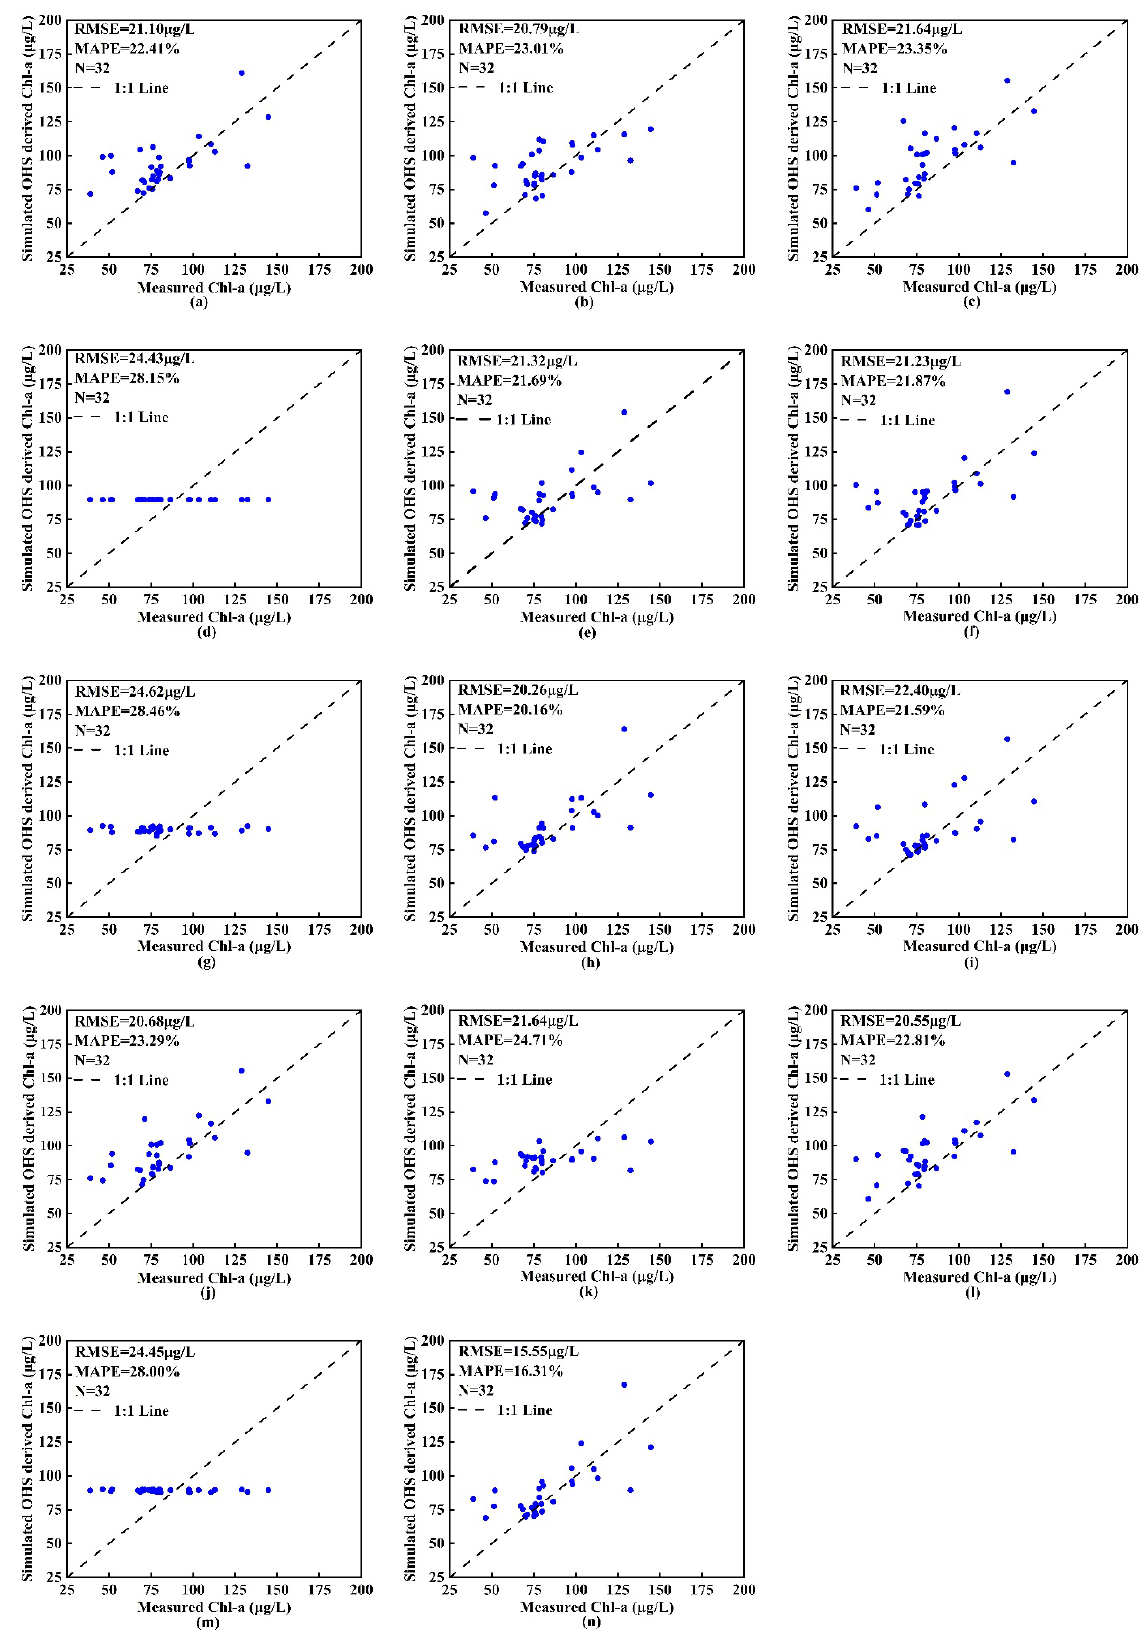
Figure A4. Comparison of the results of existing Chl-a concentration retrieval algorithms based on OHS imagery. ( a – n ) are the validation of the reconstruction models in Figure A3 in turn.